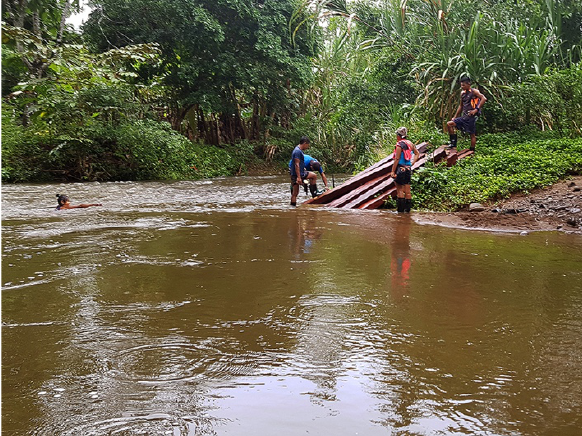
Figure 5. Transporting wood along a river in Naso